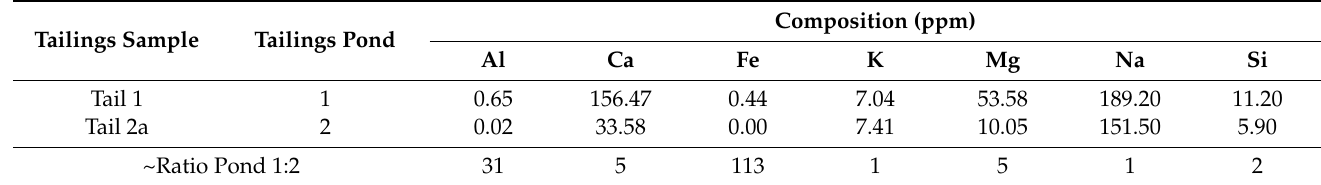
Table 3. Chemical composition of tailings storage facilities, measured via